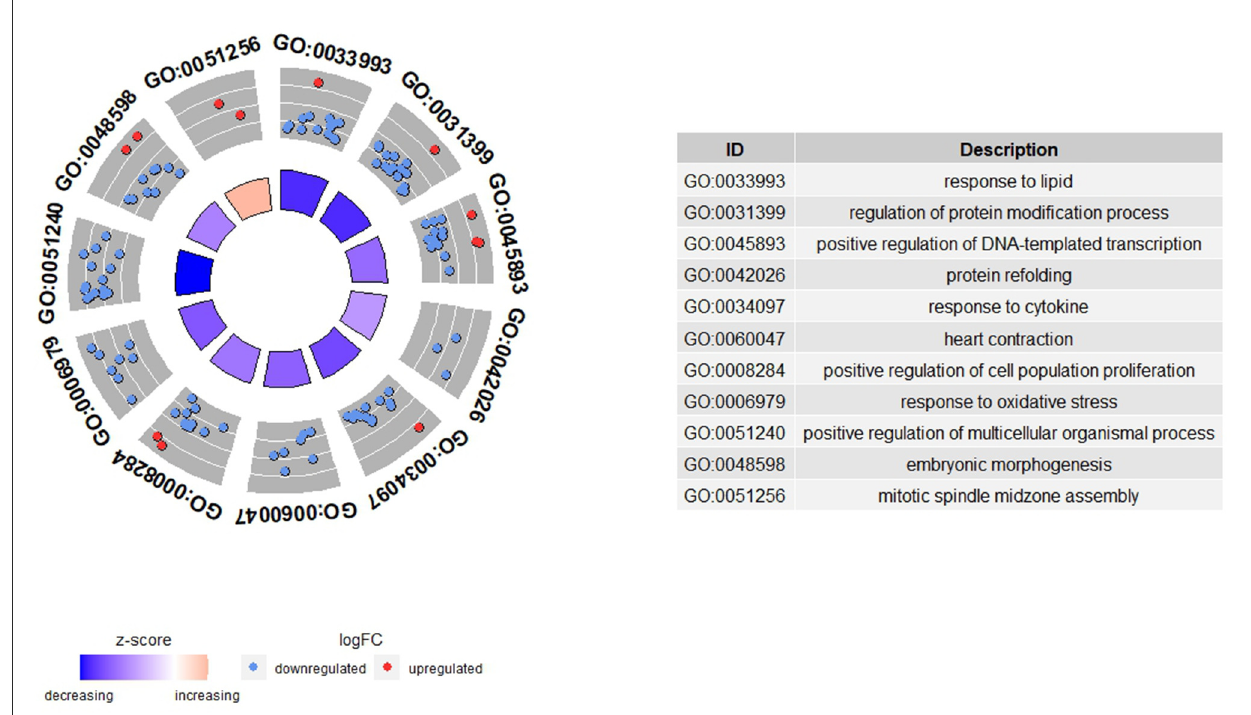
FIGURE1 Functional enrichment results from the differential gene expression analysis between high (H-FE) and low (L-FE) feed efficiency animals. In the GOCircle plot, the significant GO terms enriched (FDR < 0.05) after a reduction of the terms with a gene overlap > 80% are represented. The outer circle shows a scatter plot for each GO term of the logFC of the genes clustered in the term. The blue circles are genes downregulated in H-FE, while red circles are upregulated genes in H-FE sheep. The inner circle shows a bar plot representing the z -score for each GO term. The red bar means that the GO term is upregulated for H-FE, while the blue bar indicates the GO term is upregulated for